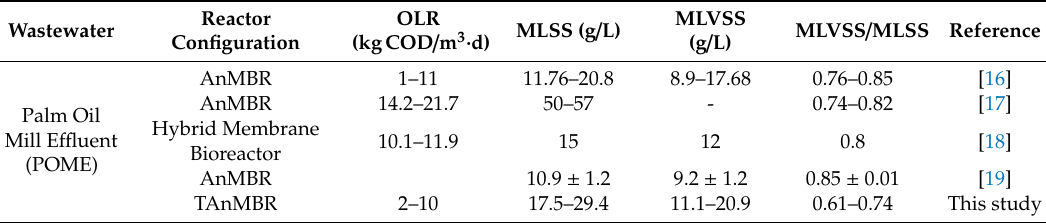
Figure 4. MLSS and MLVSS concentrations during the TAnMBR operation. Table 2. MLVSS / MLSS Ratio: Comparison between the current study and the literature.